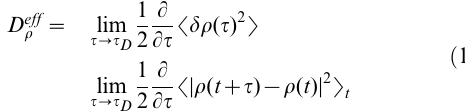
where S ::: T t indicates an average over all simulated frames that are separated by a given value of t , and t D is the timescale